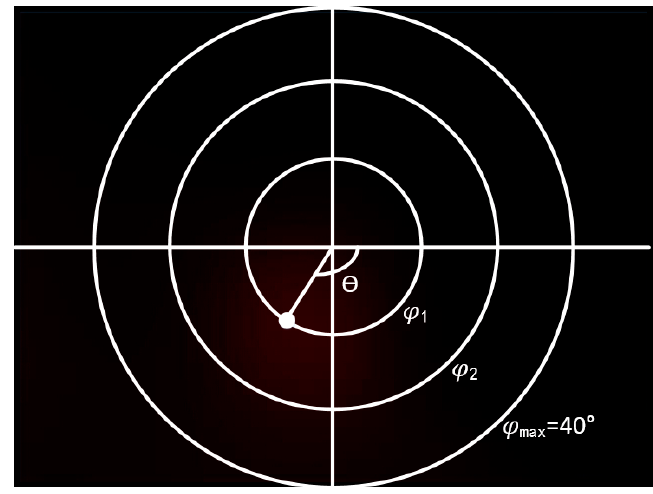
Figure 3. Relationship between spatial spectrum and ultrasonic signal frame F ( z ).